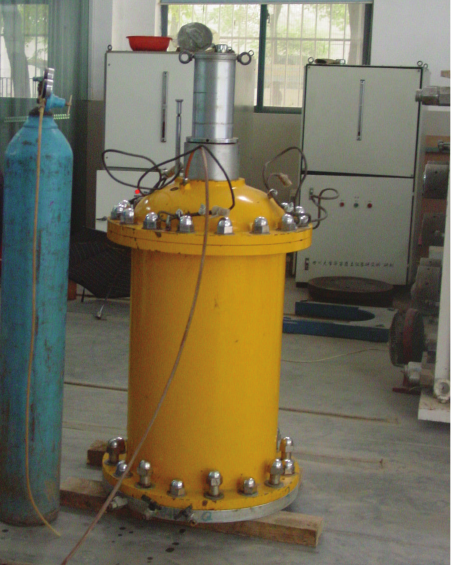
Figure 1: The triaxial test of granular media.